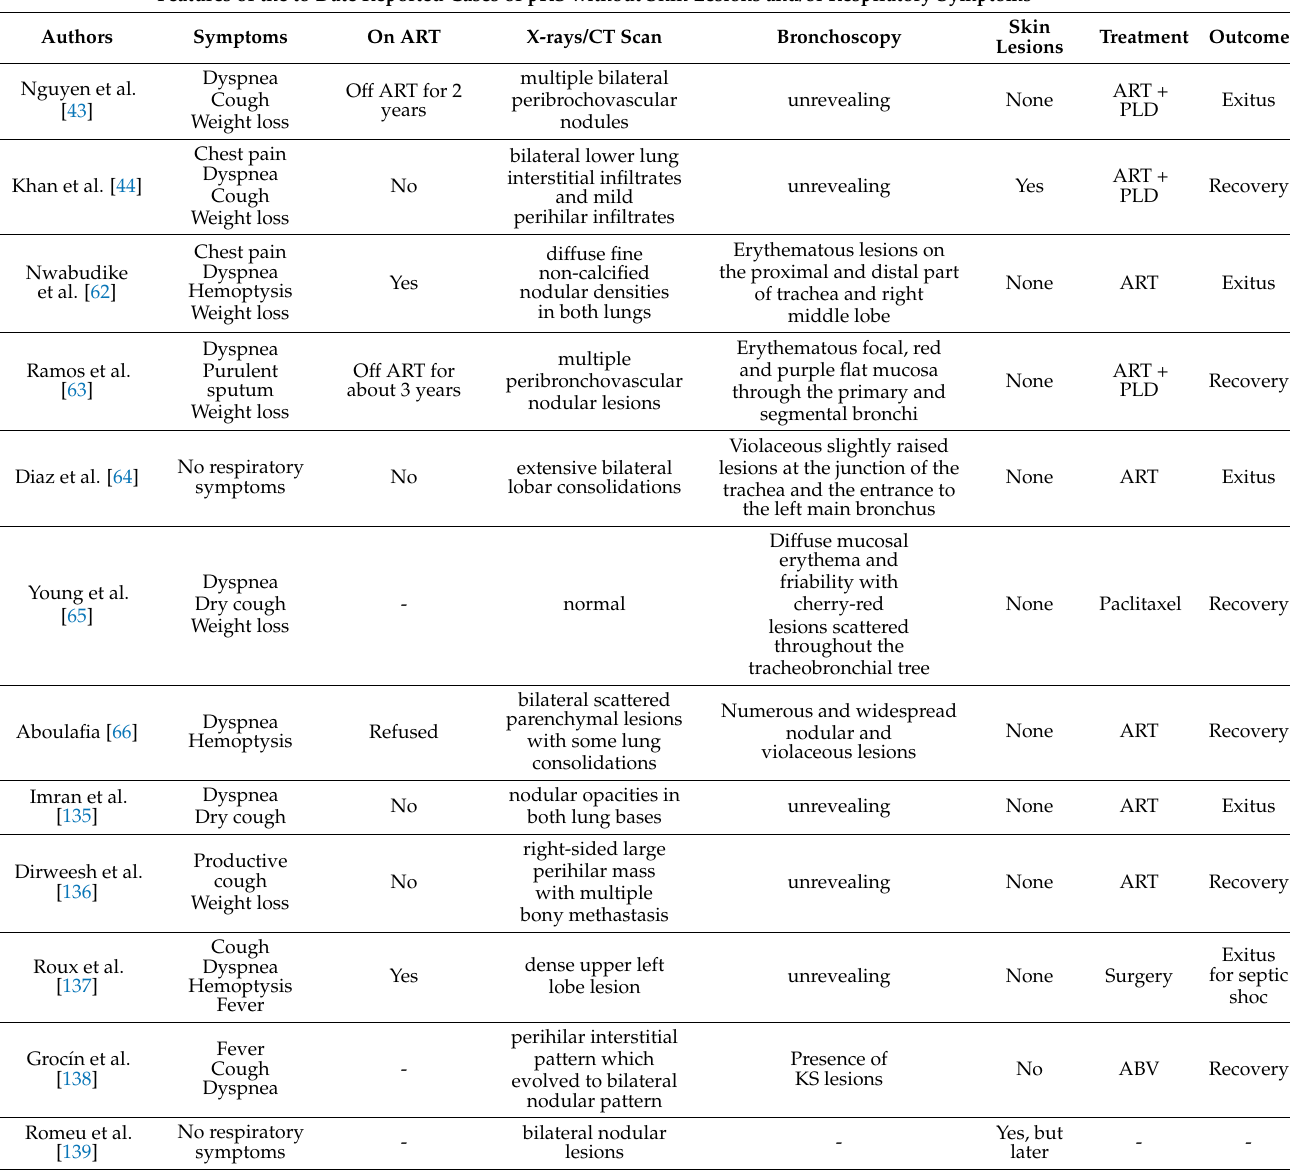
Table 3. Main features of the to date reported cases of pKS without respiratory symptoms or skin